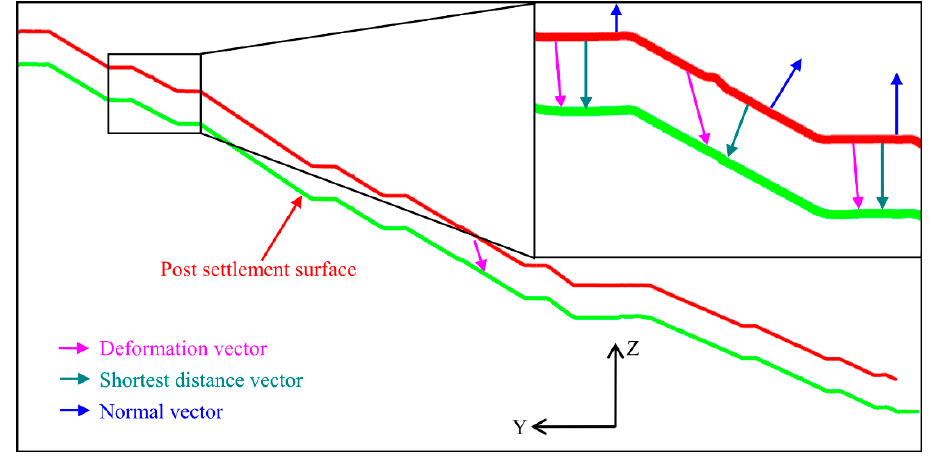
Figure 7. Conceptual comparison of the profiles.